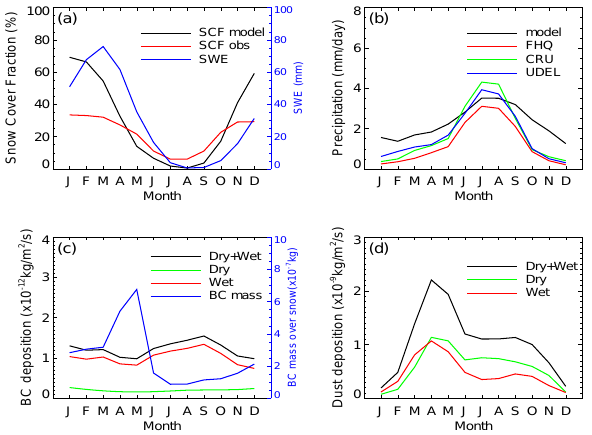
Fig. 3. (a) Monthly snow cover fraction (SCF, %) and sow wa- ter equivalence (SWE,mm) from model, and SCF from MODIS; (b) monthly precipitation (mm per day) from model and three different observational datasets (see Qian and Leung, 2007); (c) dry, wet and total deposition for BC (10 − 12 kgm − 2 s − 1 ) and the mass of BC in top snow layer averaged over the areas when snow presents (10 − 7 kg); (d) dry, wet and total deposition for dust (10 − 9 kgm − 2 s − 1 )